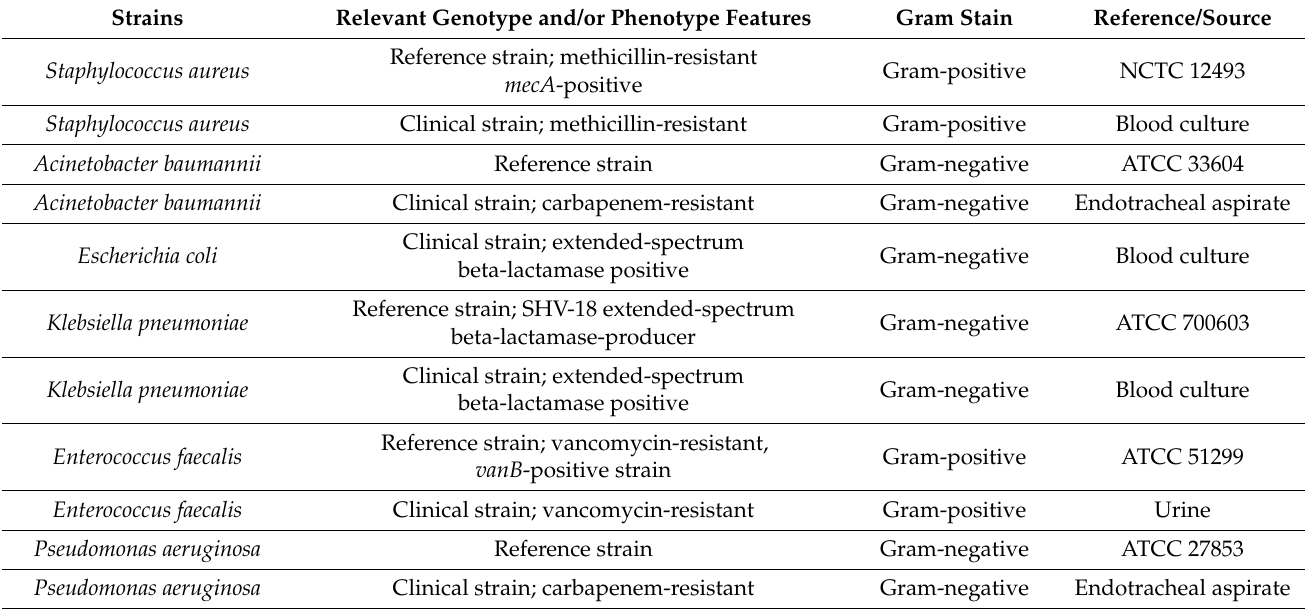
Table 1. List of bacterial strains used in the